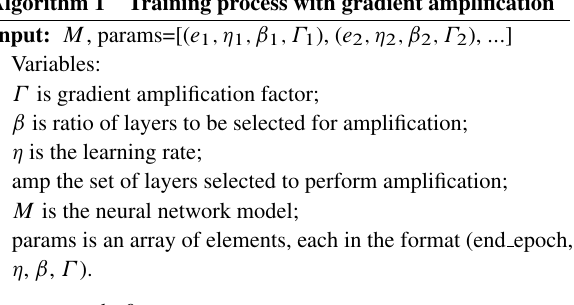
Algorithm 1 Training process with gradient amplification